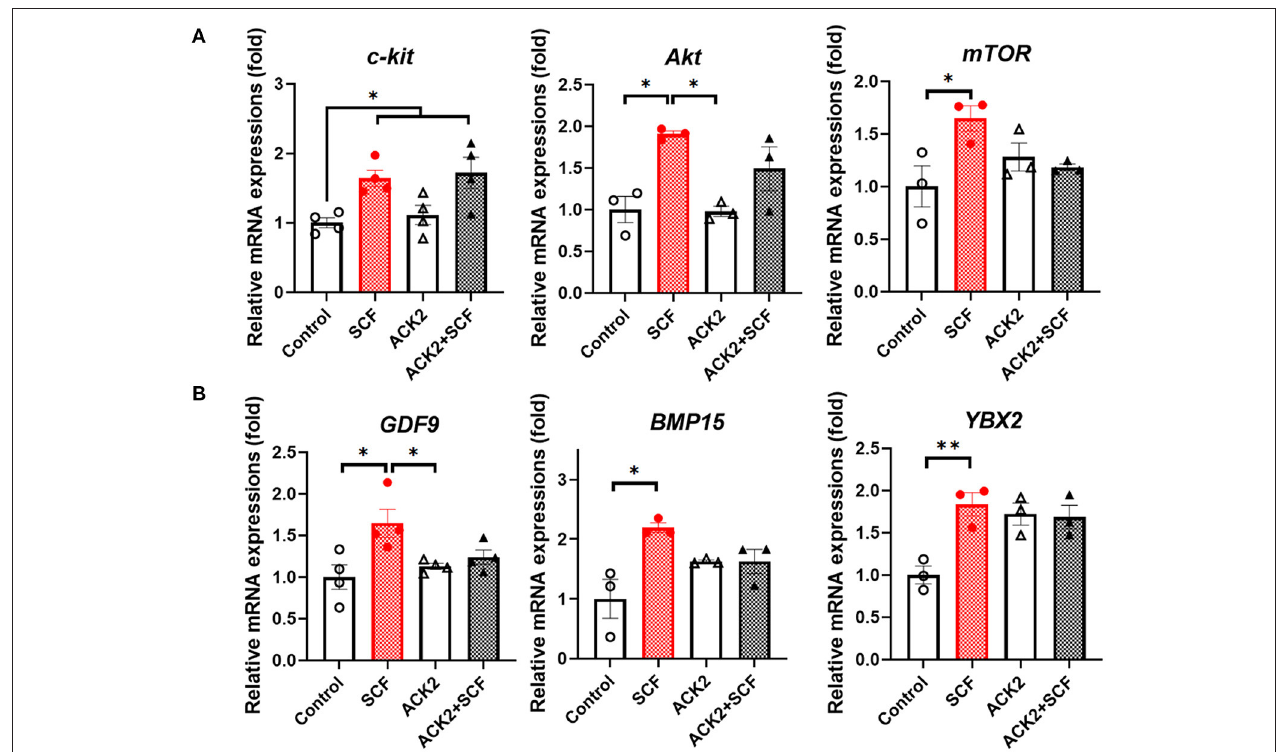
FIGURE 6 | Relative mRNA expression levels in SCF-treated porcine oocytes. (A) The mRNA levels of SCF/c-Kit signaling-related genes ( c-kit , Akt , and mTOR ). (B) The mRNA levels of oocyte secreted factors ( GDF9 , BMP15 , and YBX2 ). For all graphs, the value represents the mean ± SEM. Asterisks indicate statistical significance (* p < 0.05 and ** p < 0.01). Statistical significance was determined by one-way ANOVA. The experiments were repeated three or four